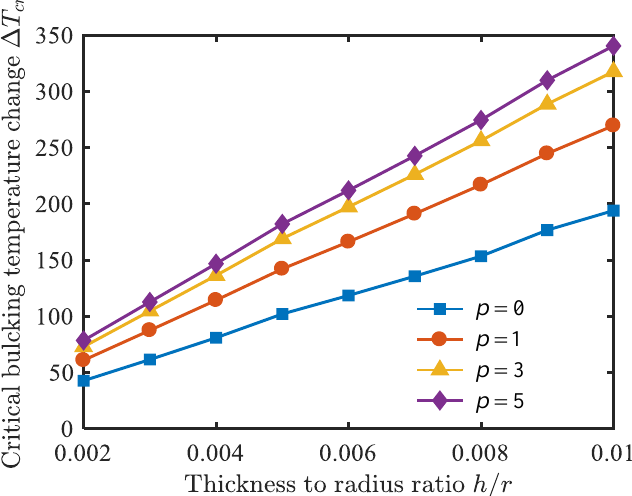
Figure 6. Influence of the thickness-to-radius ratio of the conical shell on critical buckling tempera- ture change.